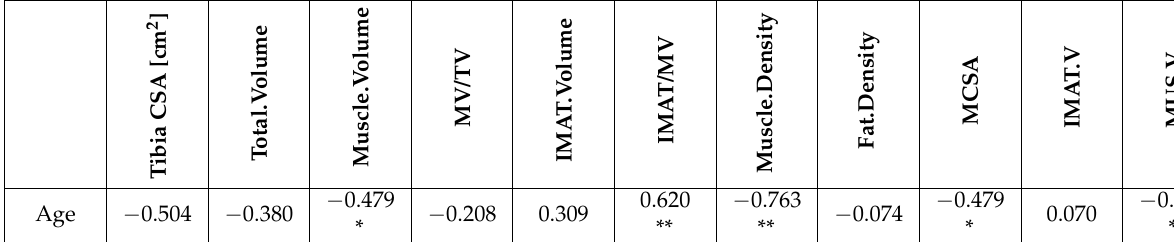
Table 1. Correlations between age and various muscle-related parameters produced by HR-pQCT.